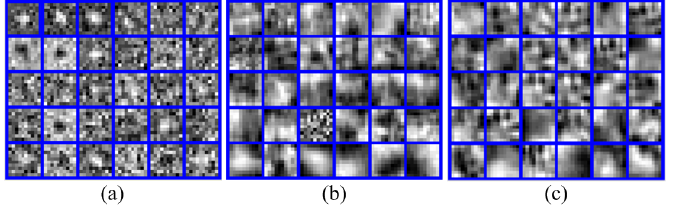
Figure 17. The kernels of different convolutional layers in MSI branch trained on EnMAP Berlin data, ( a ) kernels of the first layer; ( b ) kernels of the second layer; ( c ) kernels of the third layer.